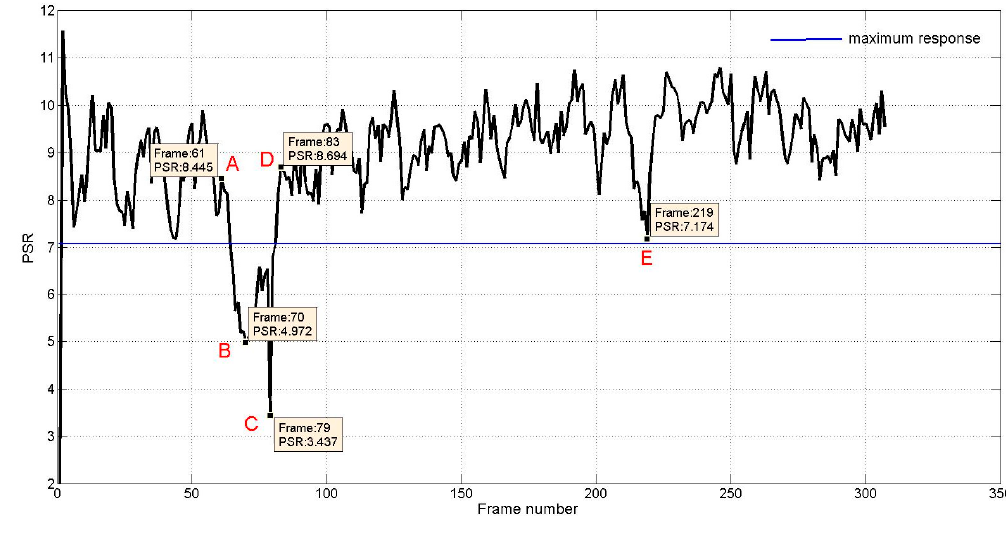
Figure 2. Peak-to-side lobe ratio ( PSR ) distribution.